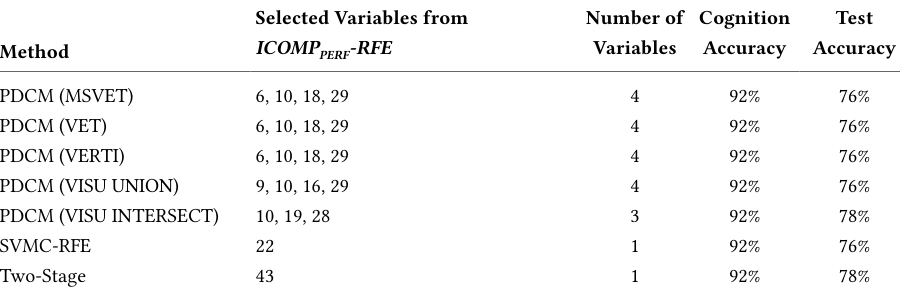
PDCM Versus Various Ranking Based Method Using Inverse Multi-Quadratic